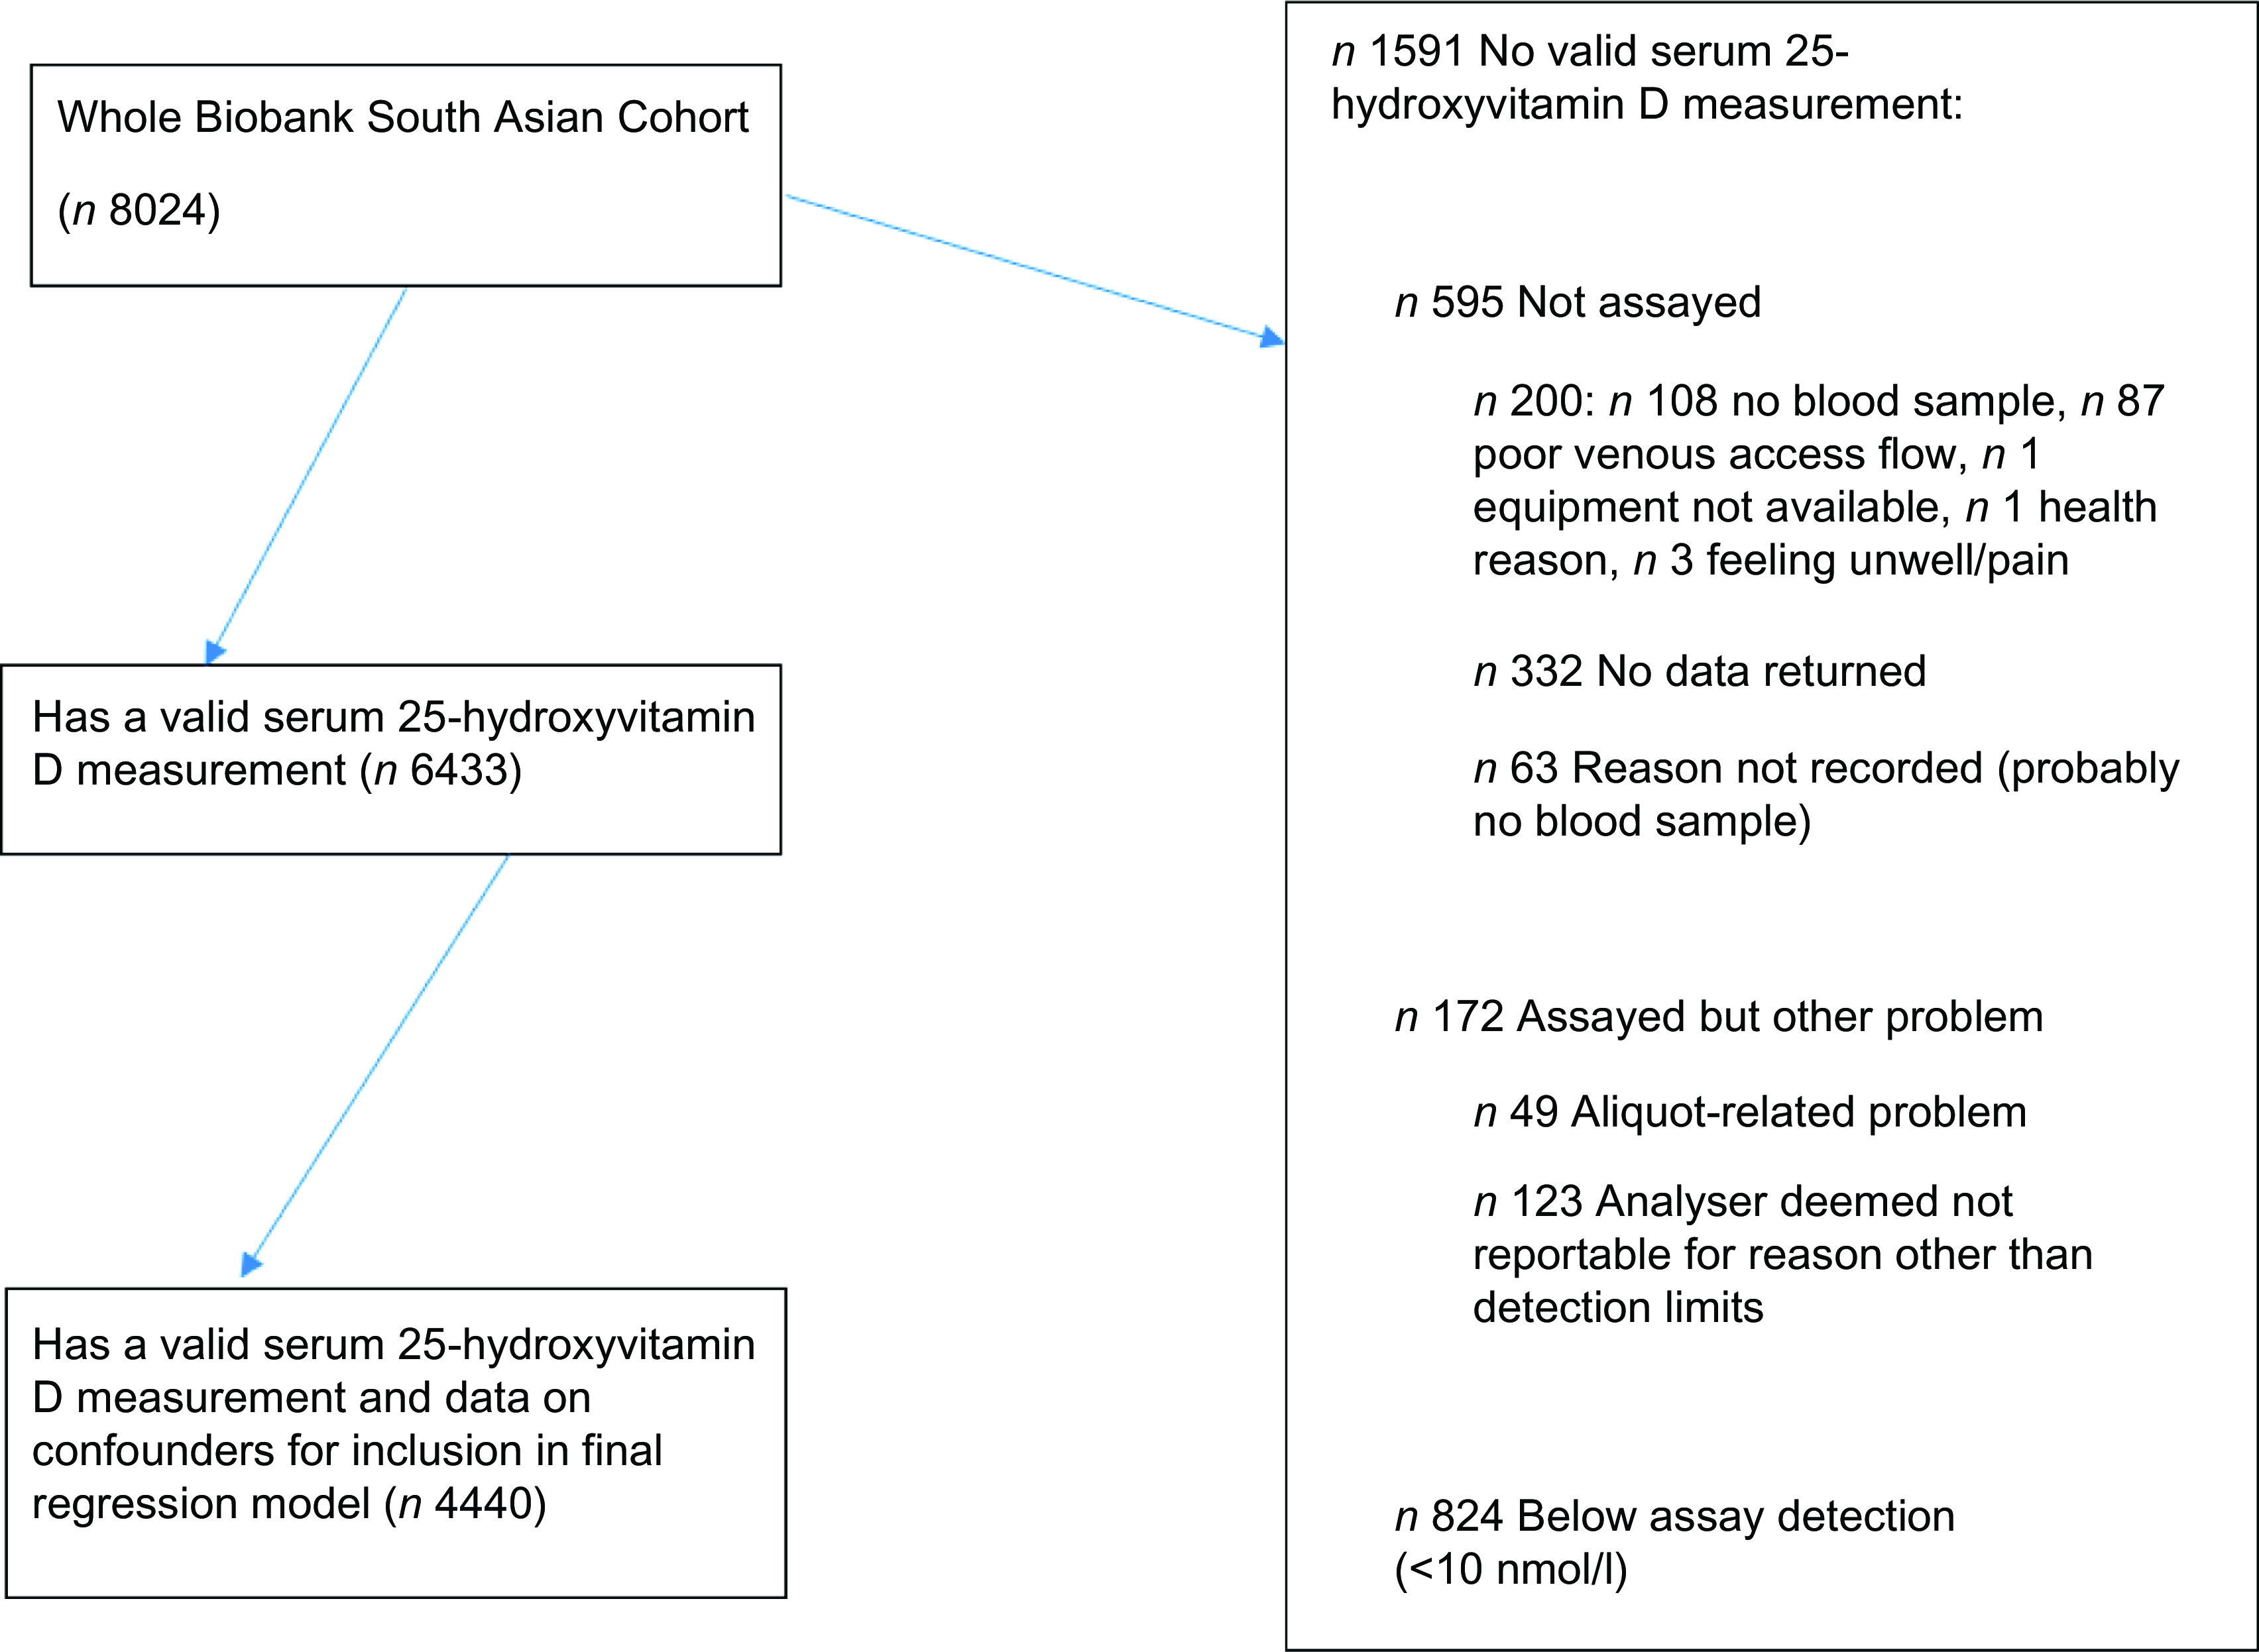
Flow diagram to illustrate flow of participants from original South Asian subset of the UK Biobank (n 8024) to those in the current analysis (n 6433) and specifically the logistic regression model (n 4440).